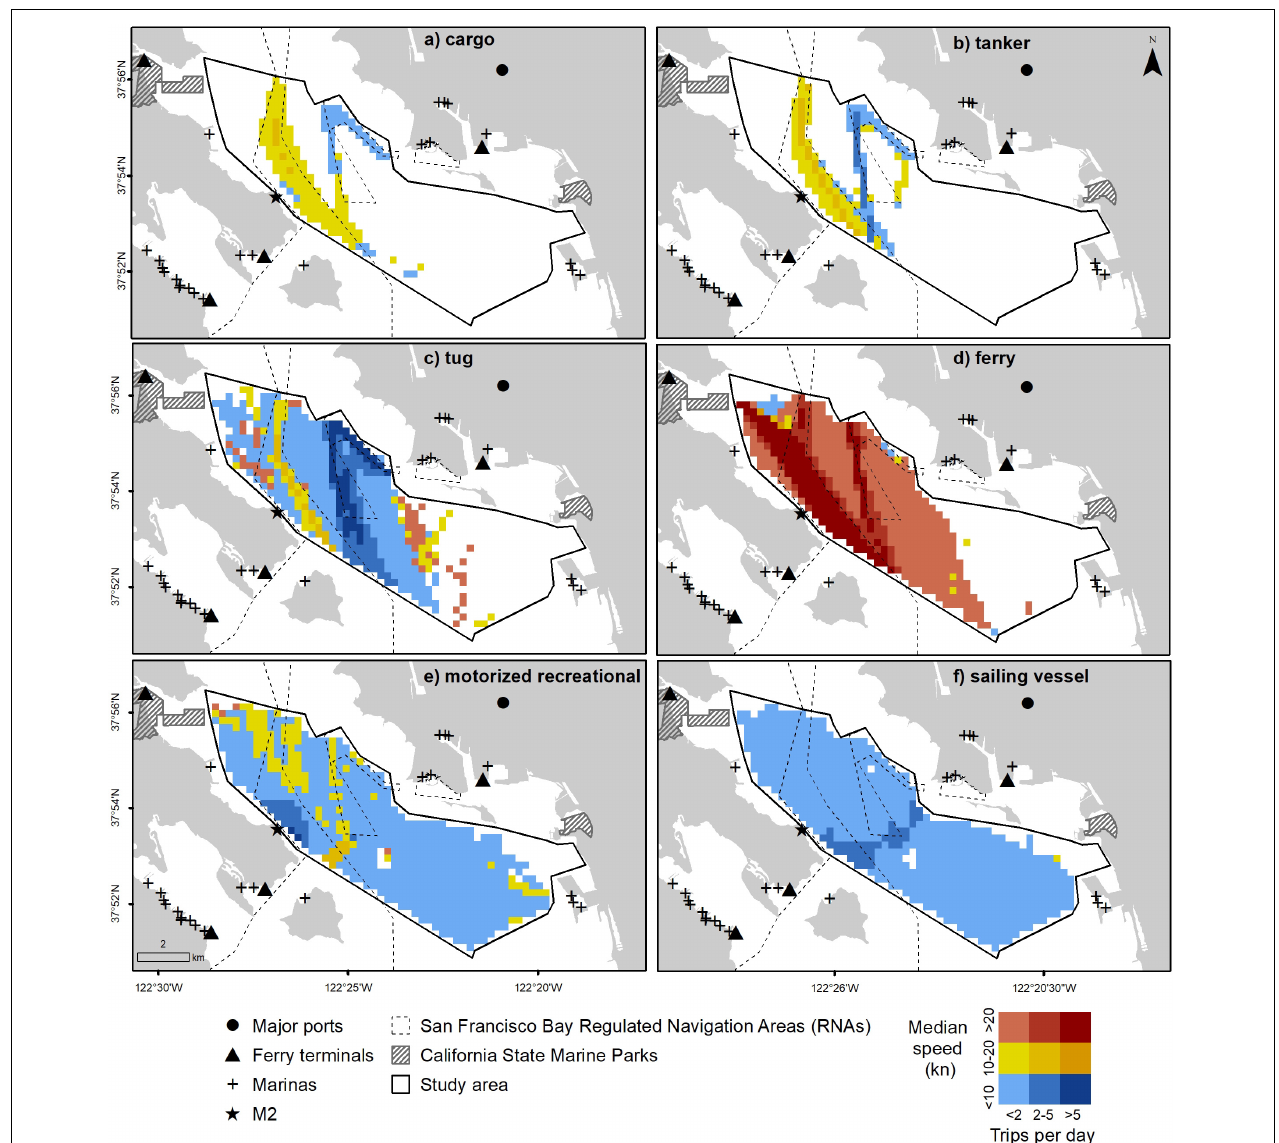
FIGURE 3 | (a-f) Spatial distribution of trips per day and median speed for cargo (a) , tanker (b) , tug (c) , ferry (d) , motorized recreational (e) , and sailing vessels (f) . Cells colored blue indicate an average speed less than 10 kn, the voluntary speed restriction used in National Marine Sanctuaries outside SFB (United States Coast Guard [USCG], 2017). Locations of major ports, marinas, protected areas (California Department of Fish and Wildlife [CDFW], 2008), and ferry terminals (Golden Gate Bridge, Highway and Transportation District, 2017; San Francisco Bay Ferry, 2018) are also shown. San Francisco Bay Regulated Navigation Areas (RNAs) were digitized according to 33 CFR